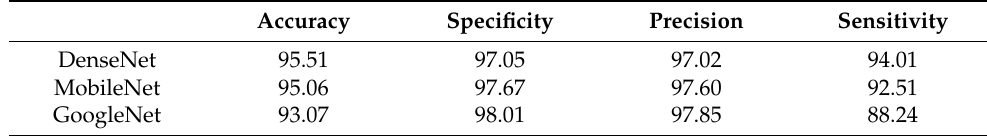
Table 3. Classification results (%) of pre ‐ trained deep models.